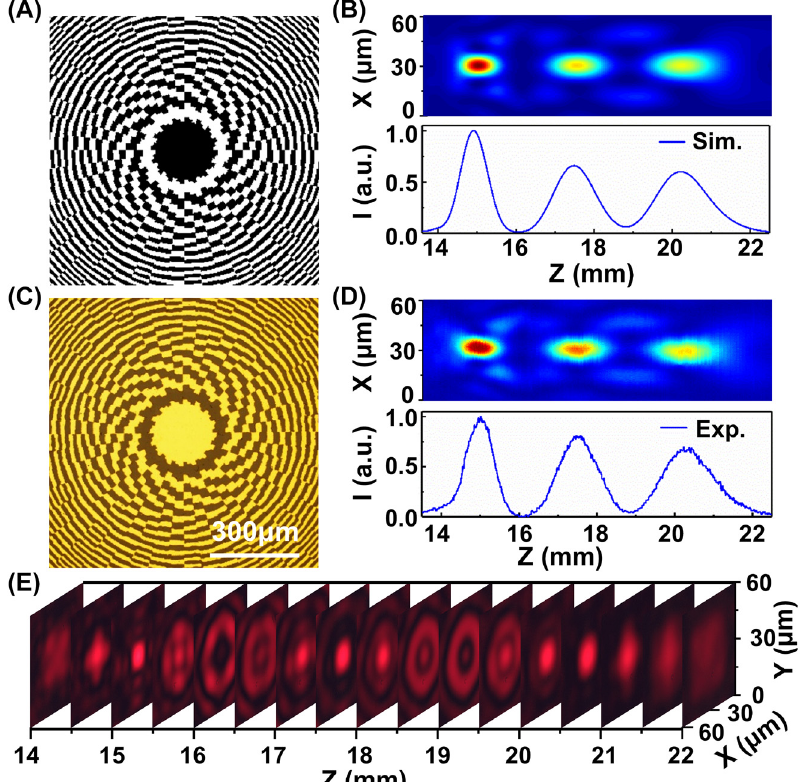
Figure3: Demonstrationofthe axialmultifo- cal zone plate. (A) Axial multifocal zone plate (600 × 600 px) developed from three FZPs with focal lengths of 15, 17.5, and 20 mm at a laser wavelength of 633 nm. (B) Simulated longitudinal intensity distribution in the XZ plane and the normalized intensity profile along the Z -axis of the diffracted optical fields through the multifocal zone plate. (C) Microscopy image of the fabricated multi- focal zone plate. (D) measured longitudinal intensity distribution and the corresponding normalized intensity profile. (E) measured intensity distributions in different XY planes along the optical